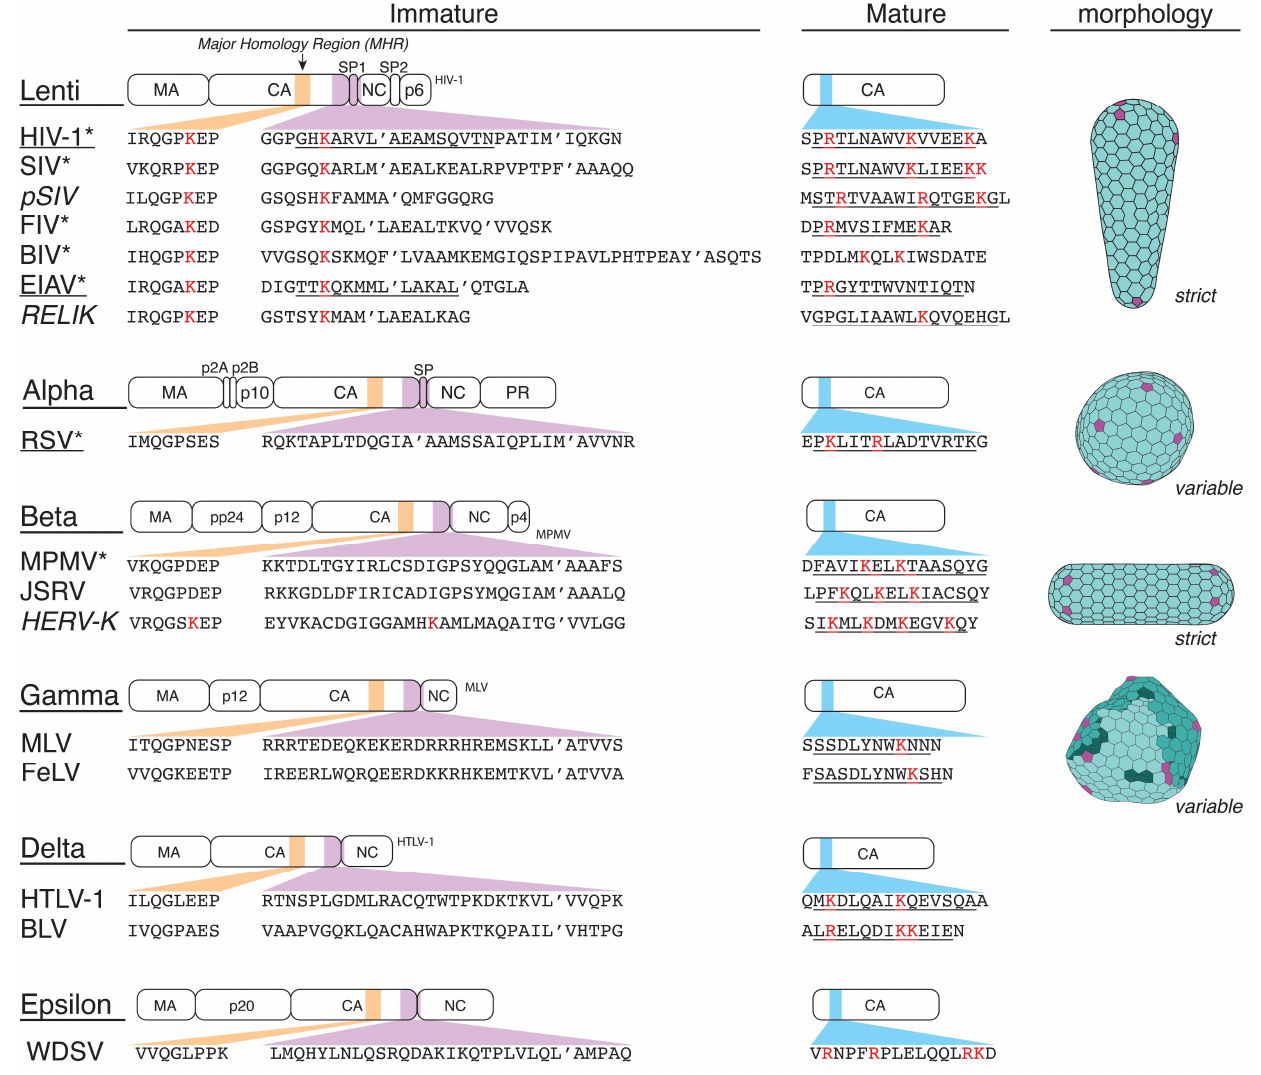
Figure 3. Retrovirus sequence comparison. The immature IP6 binding site in Lentiviruses in the MHR and CA CTD SPNC region (immature) and CA helix 1 (mature). Lys (K) and Arg (R) residues that are at or near known IP6 binding sites are in red. Simplified morphologies shown are on the right; conical, spherical, cylindrical, nested cores (layering). A minimum of one sequence is displayed for each retrovirus. * = retroviruses with reported IP6-related phenotypes. Italics = endogenous retroviruses. Underlined = retroviruses with solved structures with an IP6 interaction. Underlined amino acid sequences correspond to known alpha-helical